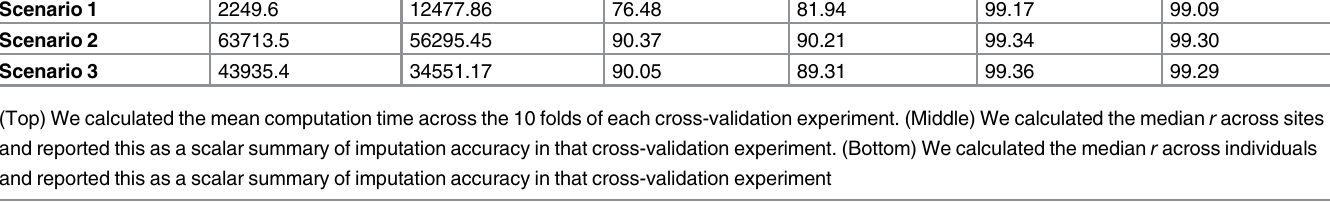
Table 1. A summary of Beagle and glmnet ’ s computation cost (in seconds) and median per-site and per-individual accuracy under scenario 1, 2, and 3. Mean run time (seconds) Median per-site r (%) Median per-individual r (%) Beagle Glmnet Beagle Glmnet Beagle Glmnet Scenario 1 2249.6 Scenario 2